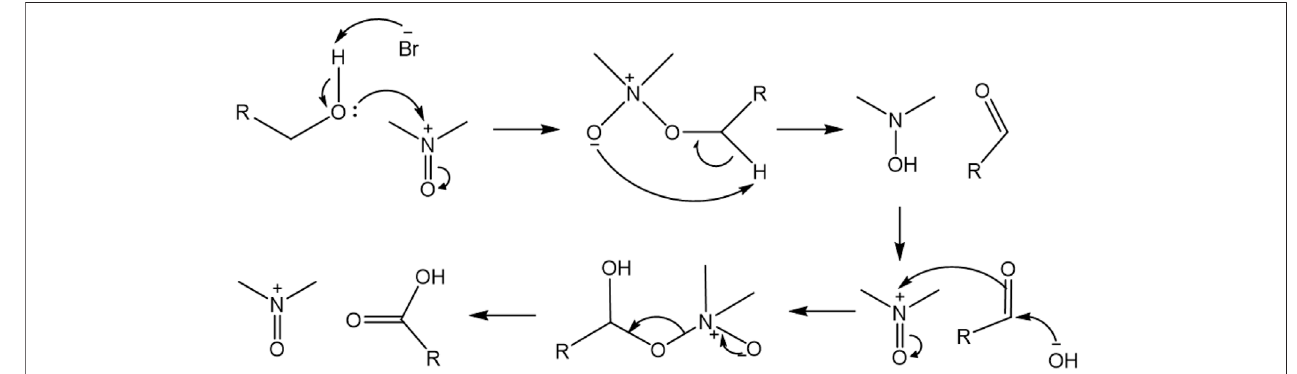
FIGURE 1 | Reaction mechanism proposed for BNC oxidation.